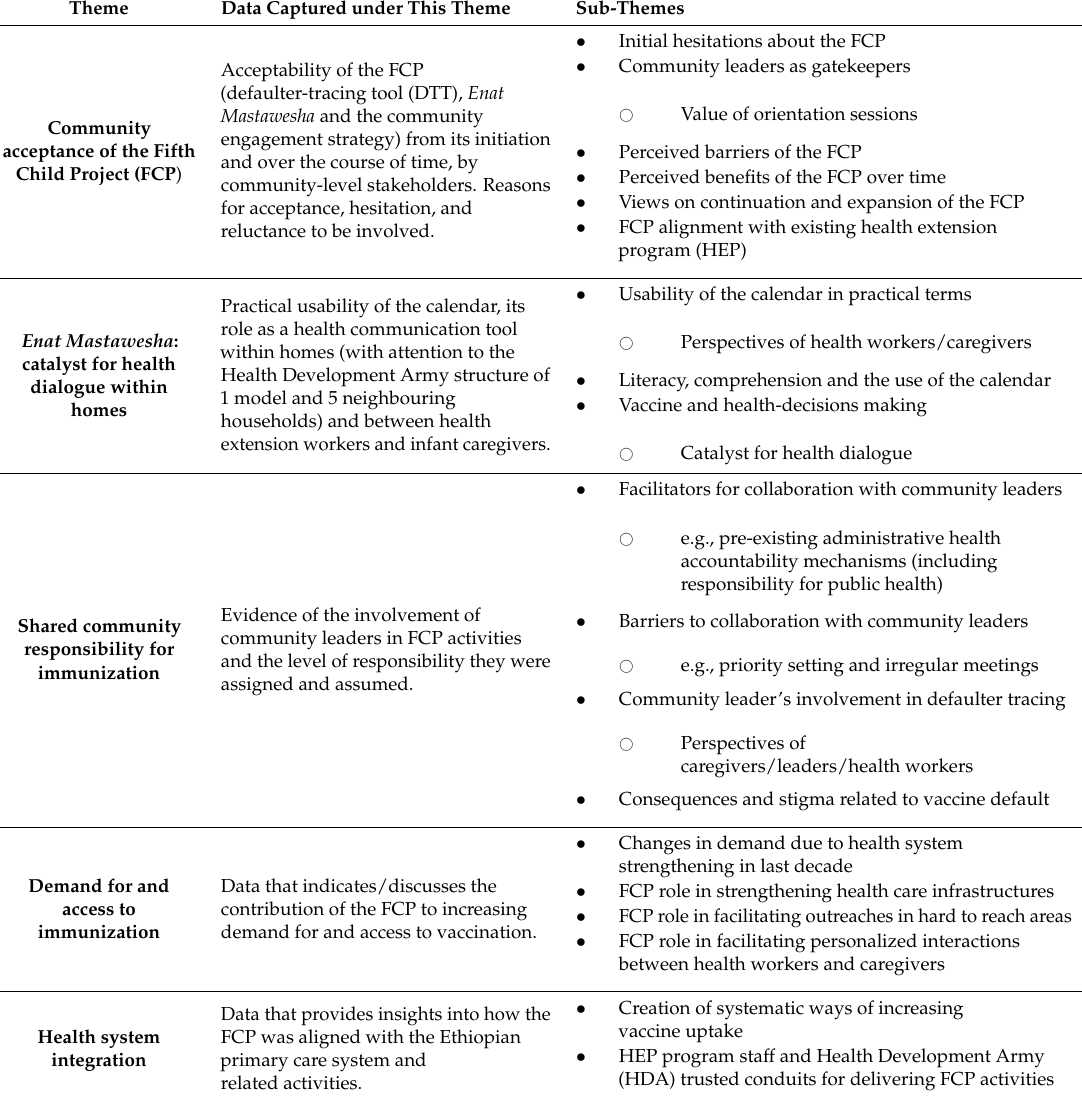
Table 3. Key themes identified from the